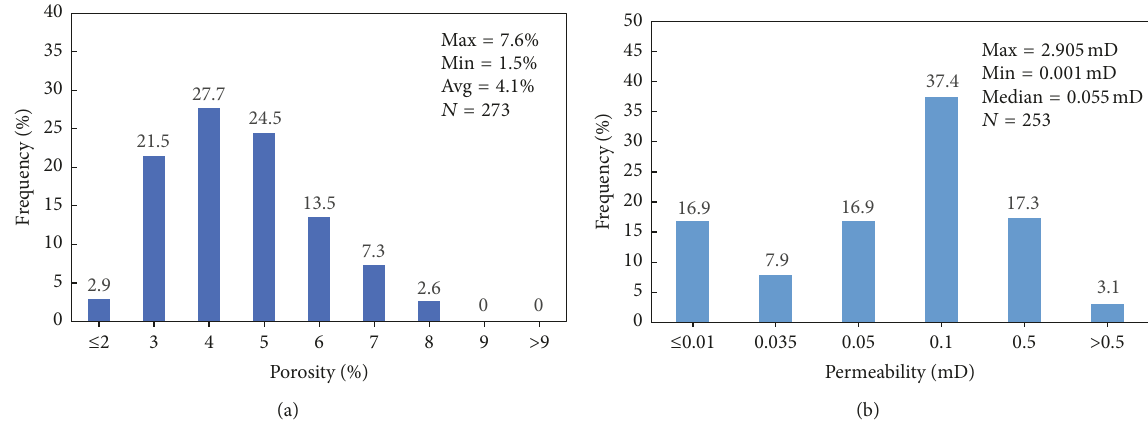
Figure 1: Core analysis results of porosity (a) and permeability (b) from over 250 reservoir rock